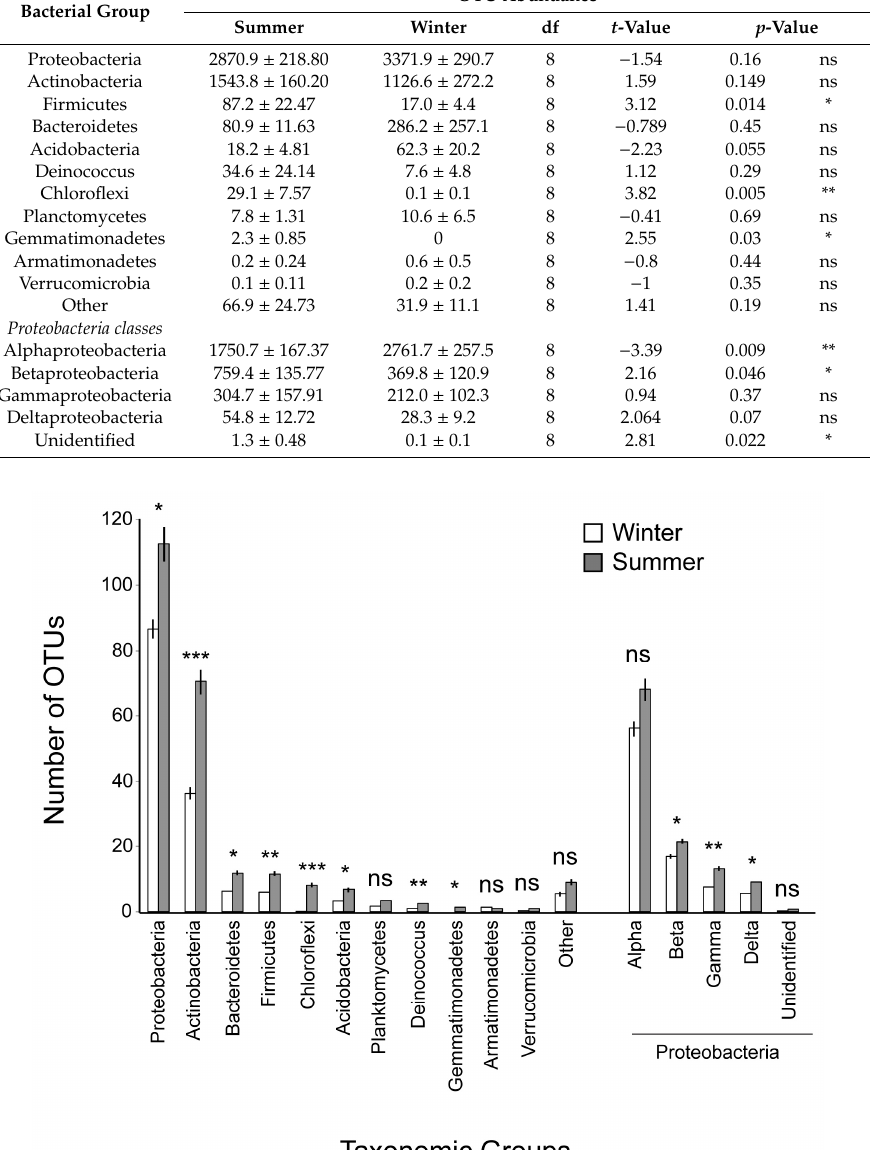
Figure 1. Number of OTUs belonging to the major high-level taxonomic groups of bacteria that were represented in the microbial community of the Mediterranean phyllosphere examined, in summer and winter, and paired t-test results. Under ‘Other’, Latescibacteria, Nitrospirae, Saccharibacteria, Spirochaetae, the WD272 group and unknown bacteria are included. For each parameter, the mean values and their standard errors are given; *: p < 0.05; **: p < 0.01; ***: p < 0.001; ns: non-significant. At a lower taxonomic level, Rhizobiales was the bacterial order represented in the phyllosphere by the highest number of OTUs (89) (Table 4). Rhodospirillales, Micrococcales,